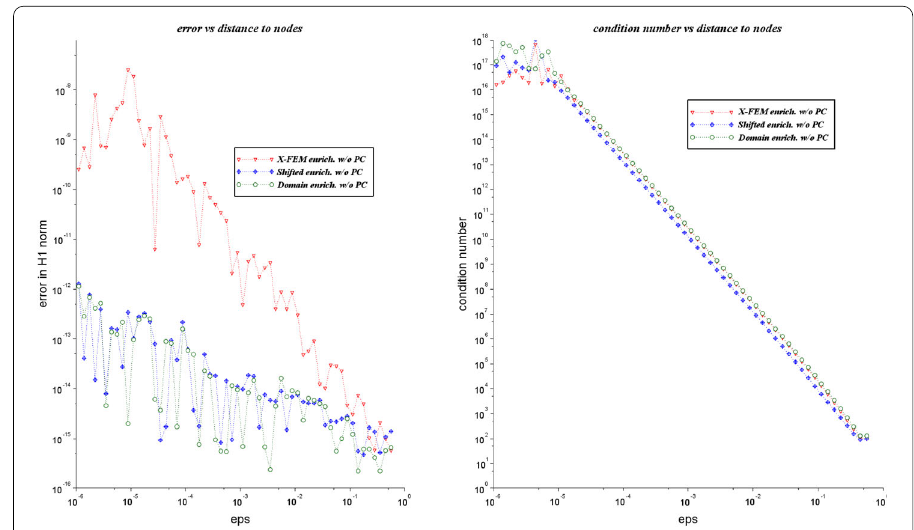
Fig. 14 H1-error and conditioning analysis with quadratic elements (Lagrange). The conditioning slopes are about three as shown is “Numerical analysis of strongly discontinuous approximations with quadratic elements” section